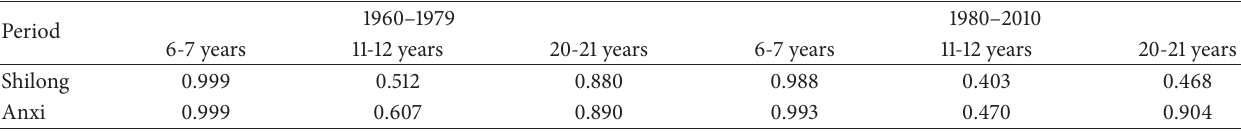
Table 3: Correlations between SPI and SSI of main period wavelet coefficient in different